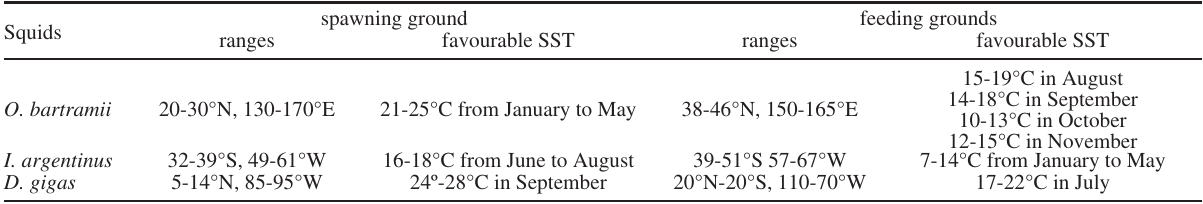
Table 2. – The favourable SSTs on the spawning and feeding grounds for O. bartramii in the northwest Pacific, I. argentinus in the southwest Atlantic and D. gigas in the southeast Pacific. spawning ground feeding grounds Squids ranges